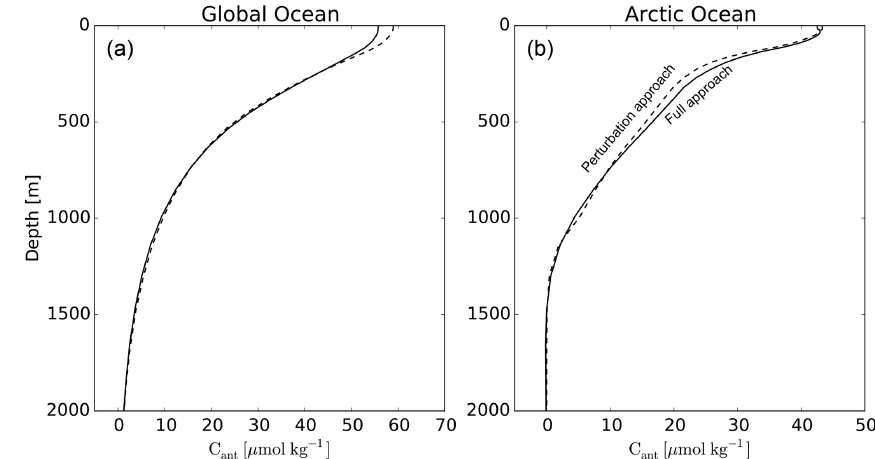
Figure A1. Mean vertical profiles of C ant for the global ocean (a) and the Arctic Ocean (b) in 2012 for the full biogeochemical approach (B1870-ORCA2 ∗ ) (solid) and the perturbation approach (P1870-ORCA2 ∗ ) (dashed).